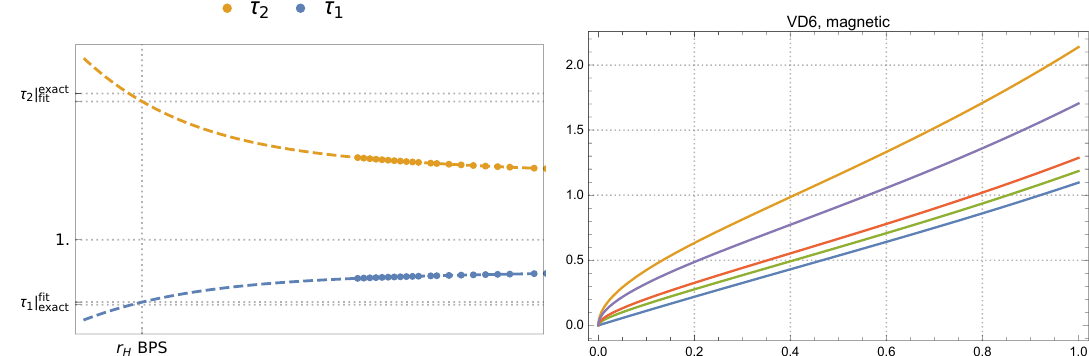
Figure 12 . On the left, extrapolated values for τ 1 and τ 2 . Note that the horizontal axis is not the u coordinate within a single solution, but rather the value of r that labels different solutions: H each of the solid points indicates a numerical solution. The lowest temperature we obtain is T ∼ 0 . 0003 . On the right: probe potential as a function of u for solutions with magnetic charge that approximate the BPS solution of [38]. The temperatures are: T = 2 . 55 (orange), T = 1 . 71 (violet), T = 0 . 69 (red), T = 0 . 16 (green), T = 0 . 00038 (blue). From our analysis we see no sign of stable or metastable